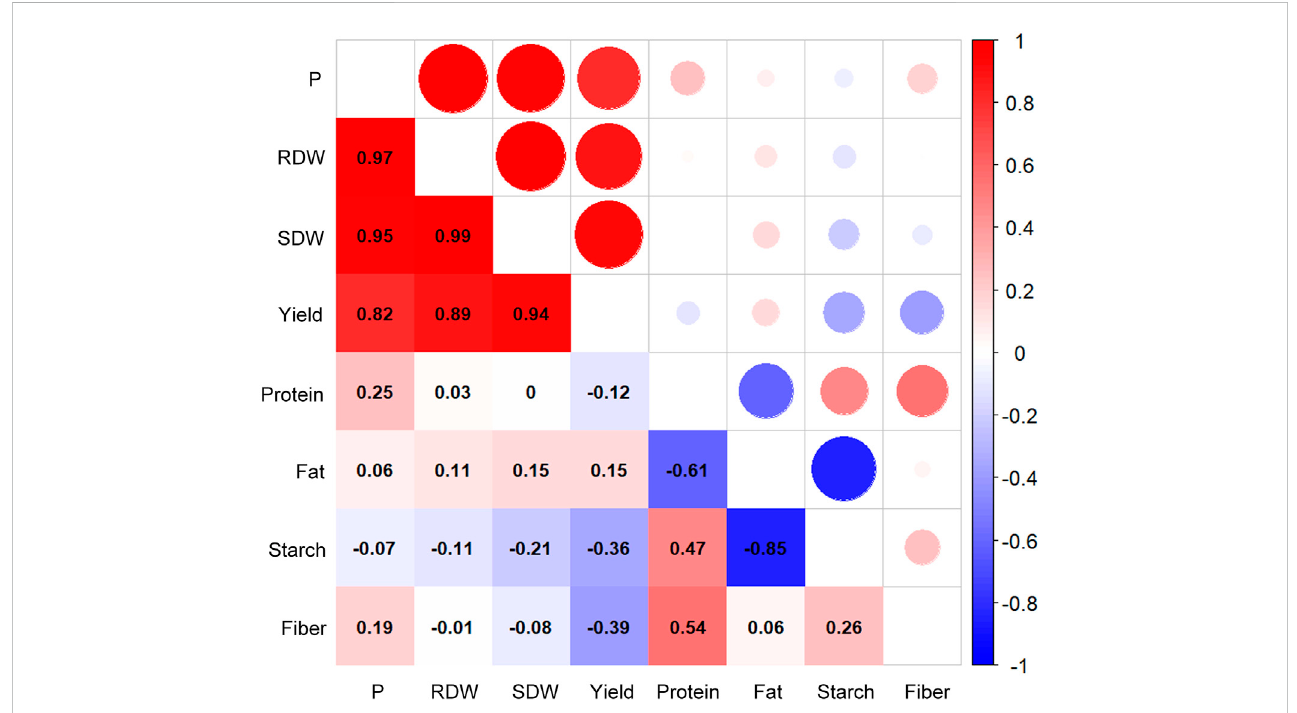
FIGURE 7 Heatmap of correlation between each pair of indices under drought fl ood abrupt alternation in summer maize farmland systems. The blue discs represent the negative correlation between the pair of indices. The red discs represent the positive correlation between the pair of indices. Note: P, soil absorption by summer maize; RDW, root dry weight; SDW, shoot dry weight; Yield, grain yield; Protein, grain crude protein; Fat, grain crude fat; Starch, grain crude starch; Fiber, grain crude fi